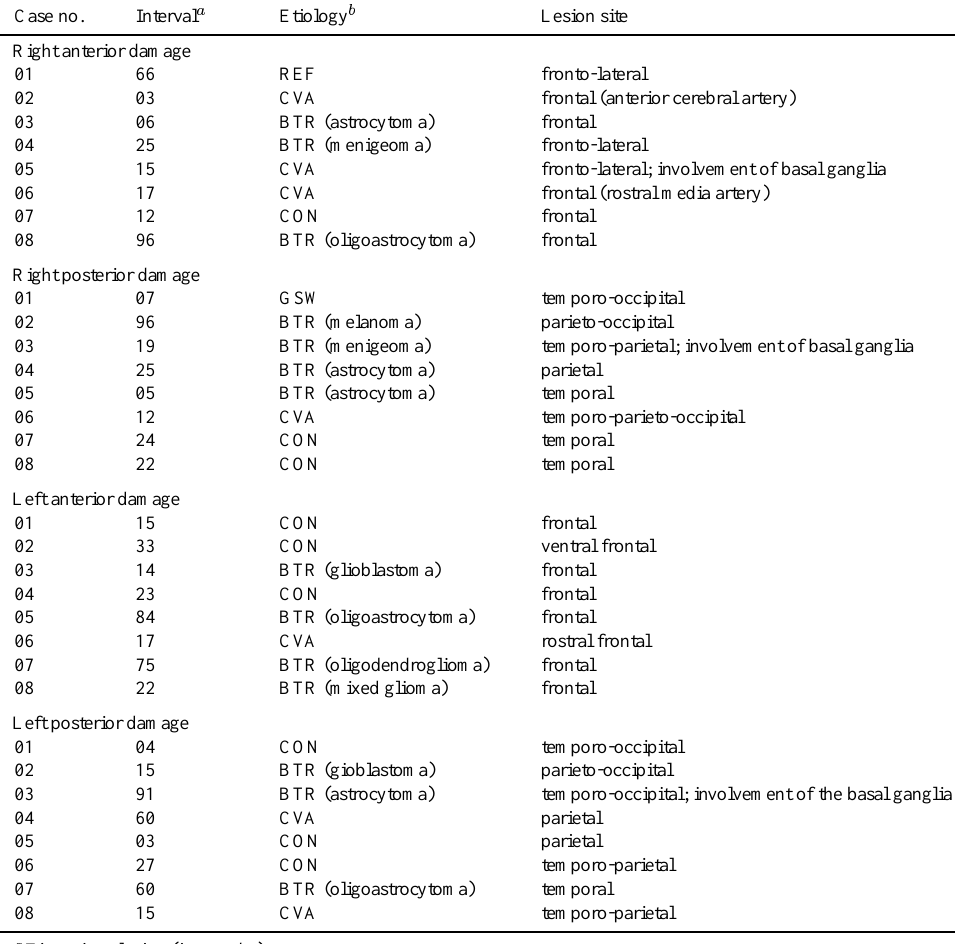
Table 1 Clinical information (patients with cortical